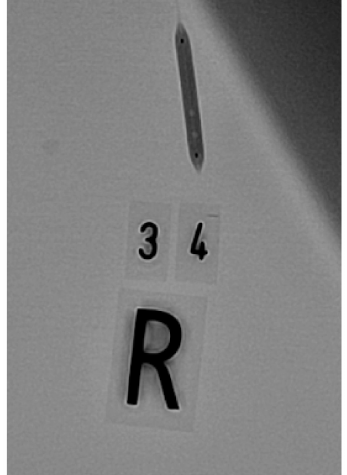
Figure 4. Balloon with two air